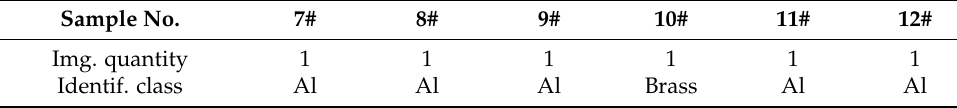
Table 8. Mass calculation. Sample No. ( b ) Figure 14. ( a ) Calculation mark of center of gravity and center of form; ( b ) Measuring the center-of-gravity with rope Scheme 9. Center-of-gravity calculation and measurement.